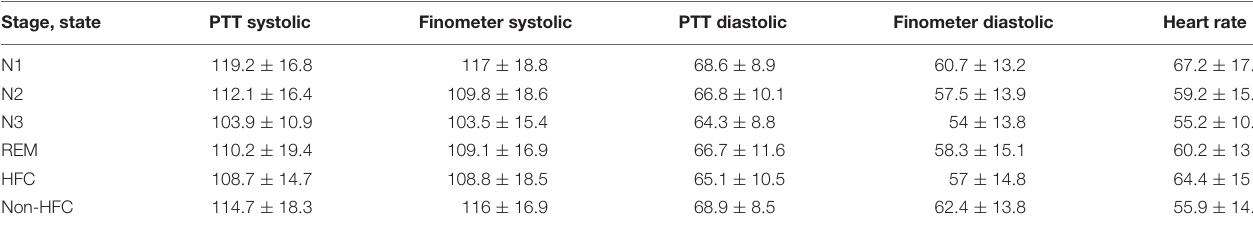
TABLE 3 | (Data-2): Beat-to-beat blood pressure in relation to sleep stage and state (11 subjects). Stage, state PTT